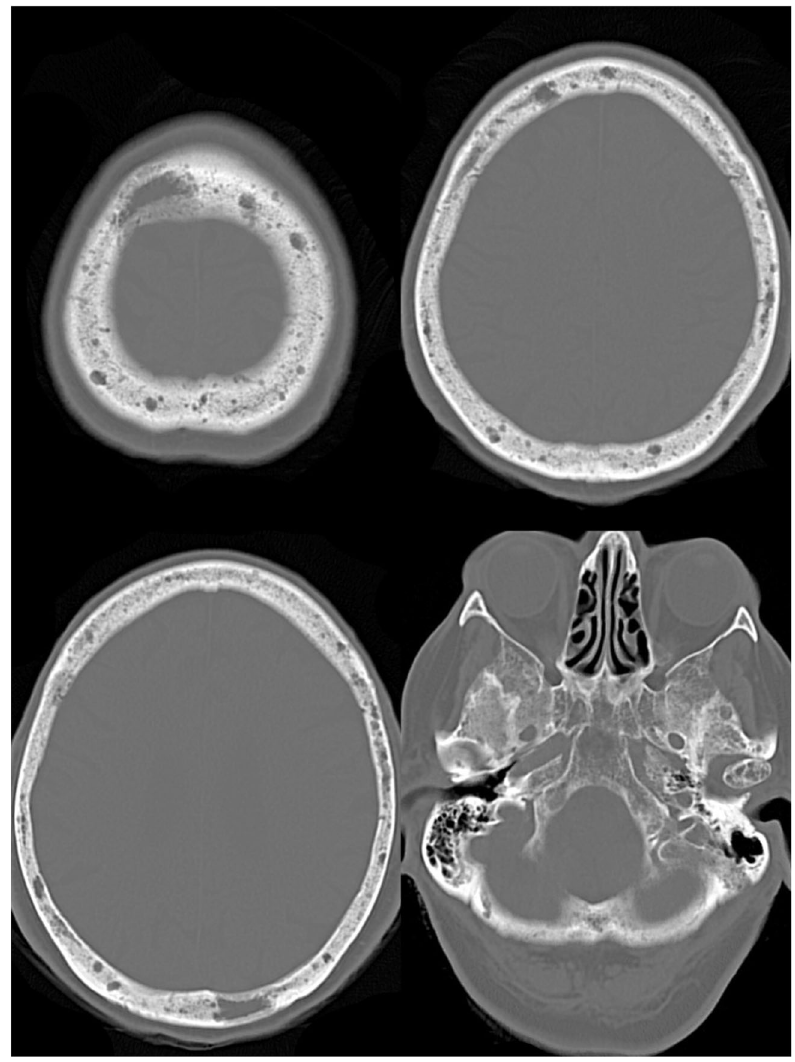
Fig. 13 Multiple myeloma (MM). Axial CT images with bone window showing multiple osteolytic lesions varying in shapeandsize,involvingthe skull vault and